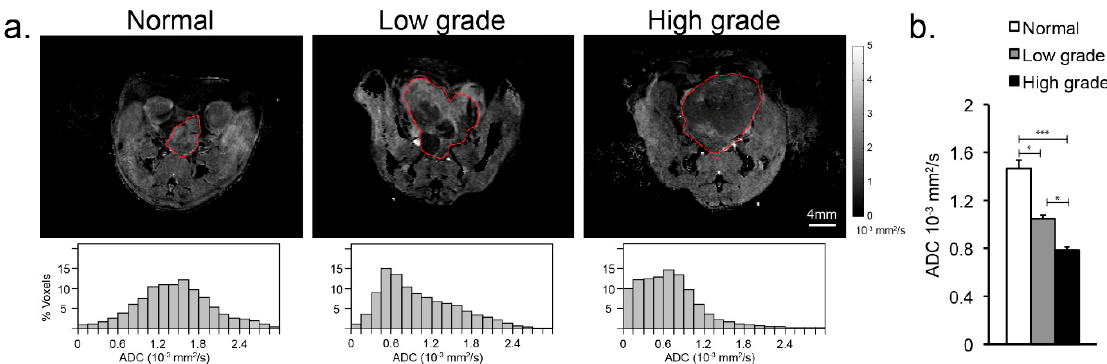
Figure 2. ( a ) (top) Representative apparent water diffusion coefficient images (ADC, outlined in red) overlaid on corresponding T 2 -weighted anatomic images of the normal murine prostate, low- and high-grade prostate cancer. ( a ) (bottom) Plots of the distribution of water ADC values across the normal murine prostate and low- and high-grade TRAMP tumors. ( b ) Bar graph of the mean ± sdev ADC values for normal prostate, high- and low-grade cancer. * denotes p < 0.05, *** for p < 0.0005.